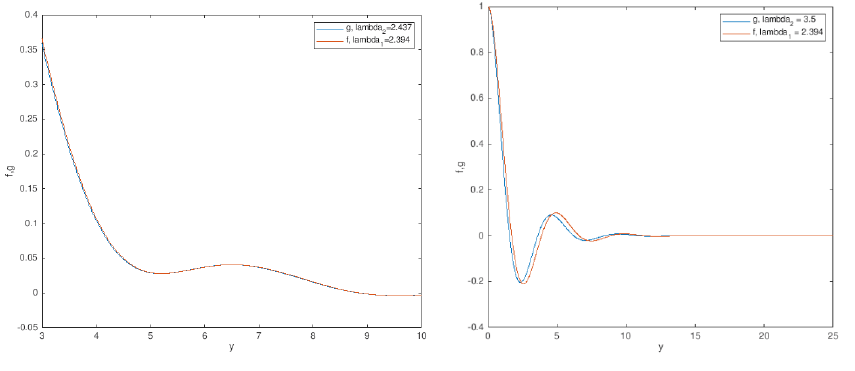
Figure 4. TW solutions for different values of TW-speeds: λ 1, f ( min ( m )) > 0 = 2.394, λ 2, g ( min ( m )) > 0 = 2.437 ( left ); λ 1 = 2.394 and λ 2 = 3.5 ( right ). Note that in this last case the first minimum of both TW is negative.